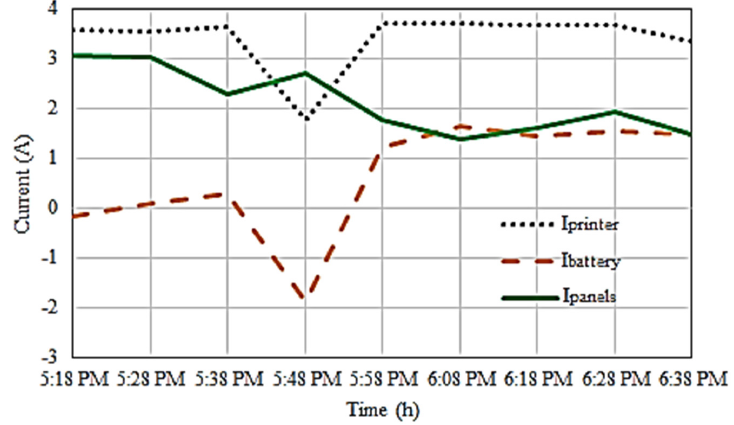
Figure 11. Variation of current across the system network during Test 2.